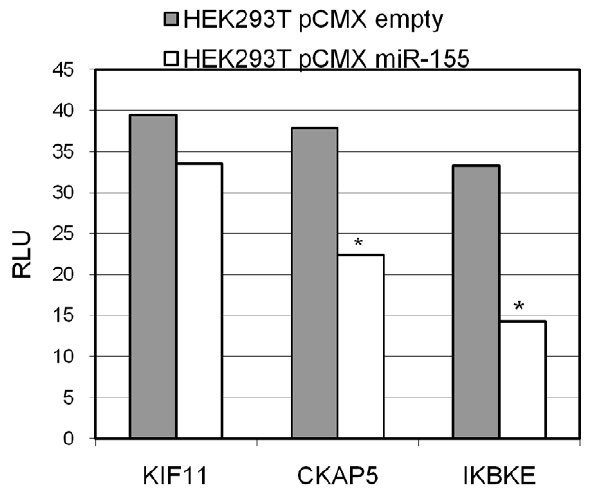
Figure 4. Luciferase reporter assays of the 3 9 UTR regions of KIF11, CKAP5 and IKBKE. The average relative light units (RLU) of six biological replicates are compared between miR-155 overexpression (HEK293T pCMX miR-155) and control (HEK293T pCMX empty). *: Student’s t-test , 0.05.